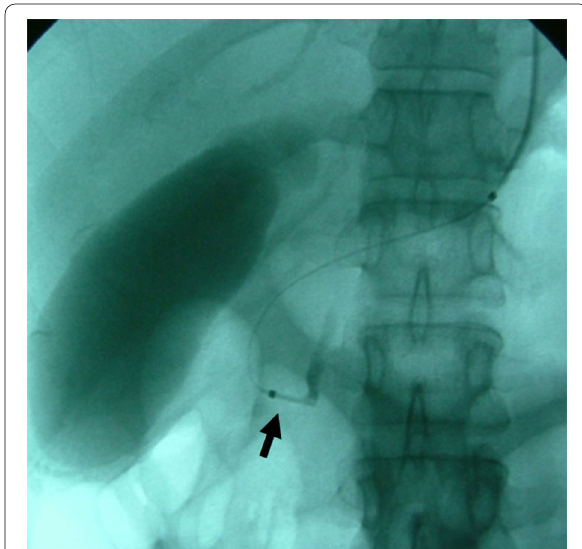
Fig. 1 Cholangiography during endoscopic balloon dilatation (EBD). The burst balloon of the endoscopic balloon dilatation (EBD) at the site of the biliary sphincter. Arrow indicates the burst balloon of the EBD catheter at the site of the biliary sphincter